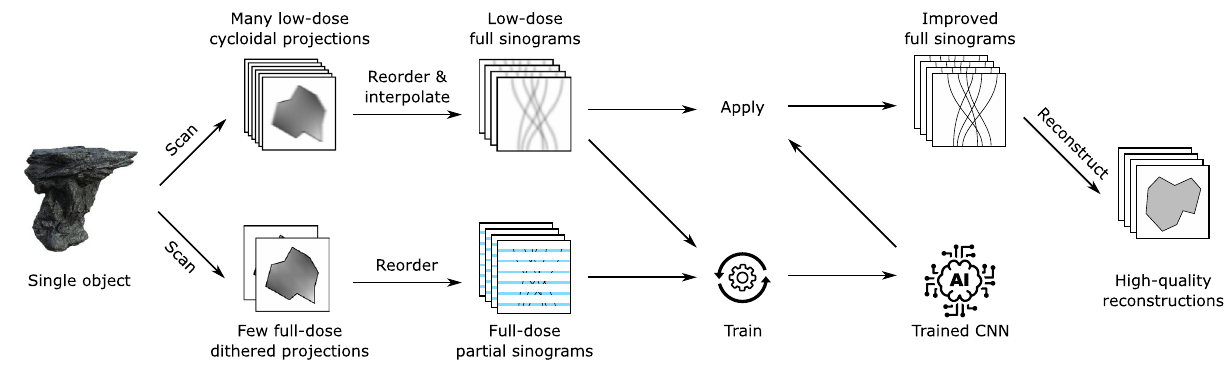
Figure 3. Schematic visualisation of the proposed training